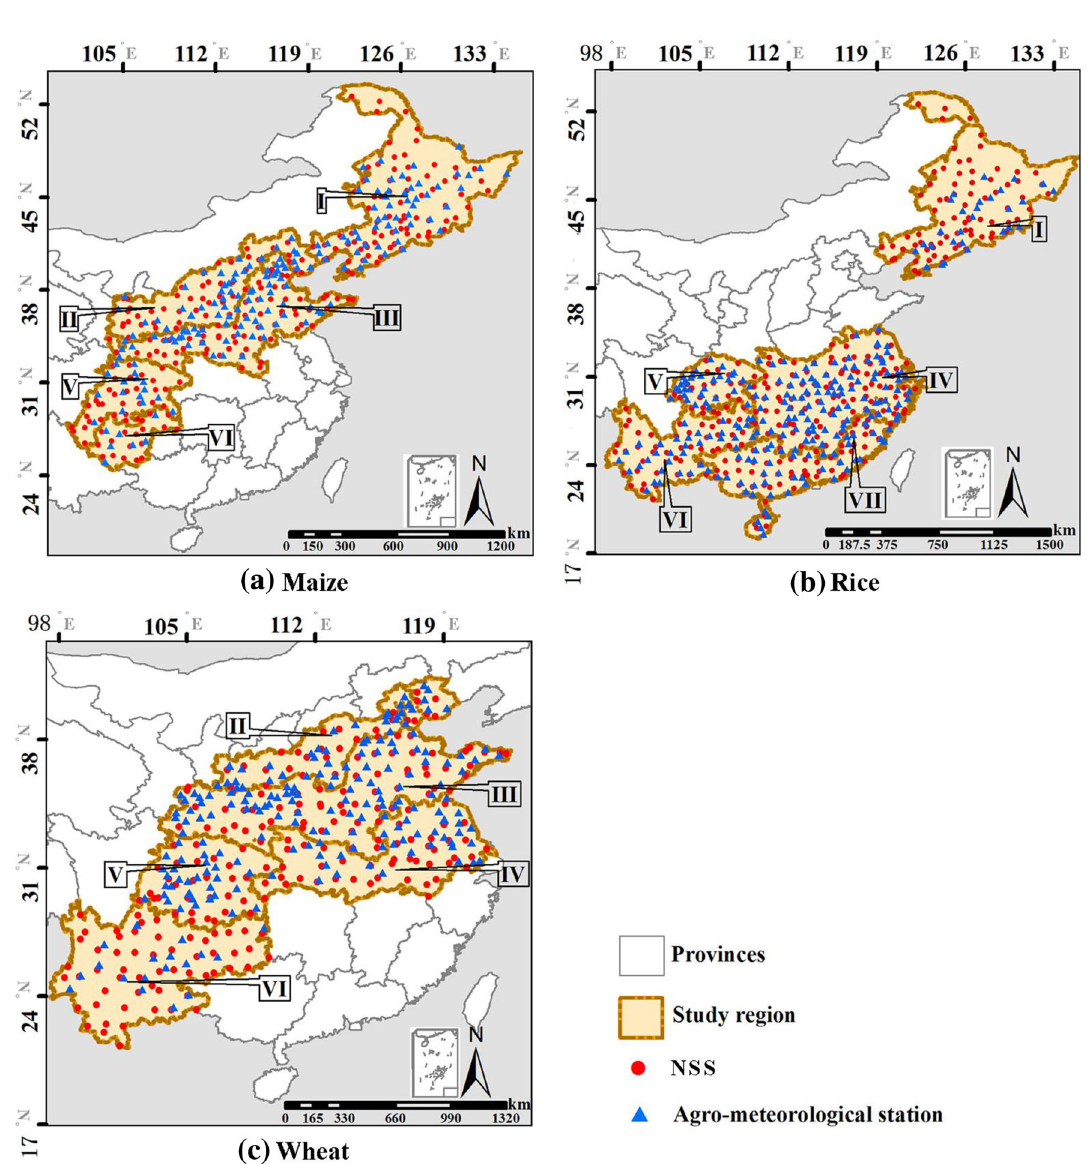
Fig. 1 The location of the study region in China, national standard stations (NSS), and agro-meteorological stations of a maize, b rice, and c wheat. The roman numerals refer to the agricultural zones listed in Table